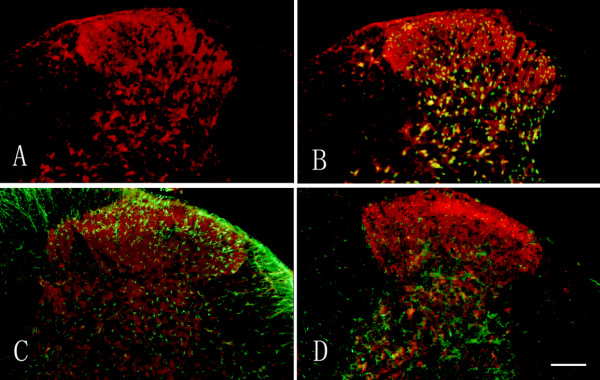
Localization of BDNF in the spinal cord after hind-paw incision. Representative photomicrographs of the double immunofluorescence of BDNF (red, Figure 2A) with NeuN-IR (marker of neuron, green in Figure 2B), GFAP-IR (marker of astrocyte, green in Figure 2C) or OX-42 (marker of microglia, green in Figure 2D). Note that abundant BDNF expressing cells were also expressed in the neurons but scarcely expressed in the astrocytes or microglia. Bar = 150 μm.